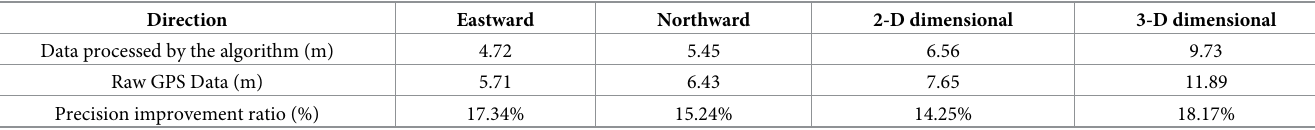
Table 4. Comparison of positioning accuracy based on Sage-Husa adaptive filtering algorithm.